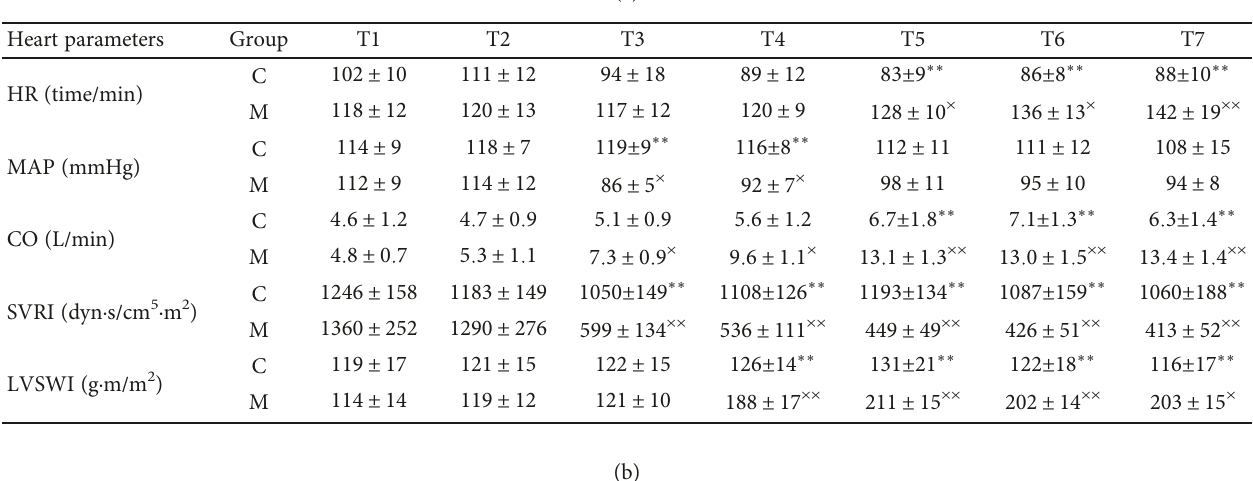
Table 1: Parameters of major organs during MODS modeling.